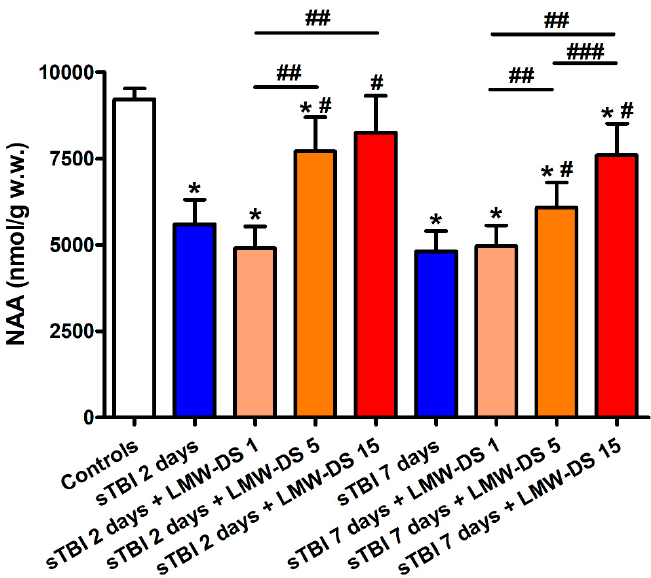
Figure 2. Effect of subcutaneous injection of increasing doses of LMW-DS (ILB ® ) on the cerebral concentrations of NAA, as a valuable indirect indicator of energy wellness and mitochondrial function. NAA was determined by HPLC on deproteinized cerebral homogenates at 2 and 7 days post-impact, both in untreated sTBI rats (TBI 2 days and TBI 7 days) and in rats receiving 1, 5, or 15 mg/kg b.w. LMW-DS (ILB ® ) administered 30 min after sTBI. Controls are represented by sham-operated rats. Values are the mean ± SD of 12 different animals and are expressed as nmol/g w.w. * Significantly different from sham-operated controls rats, p < 0.05. # Significantly different from the corresponding time point of untreated sTBI rats, p < 0.05. ## Significantly different from LMW-DS 1, p < 0.05. ### Significantly different from LMW-DS 5, p < 0.05.